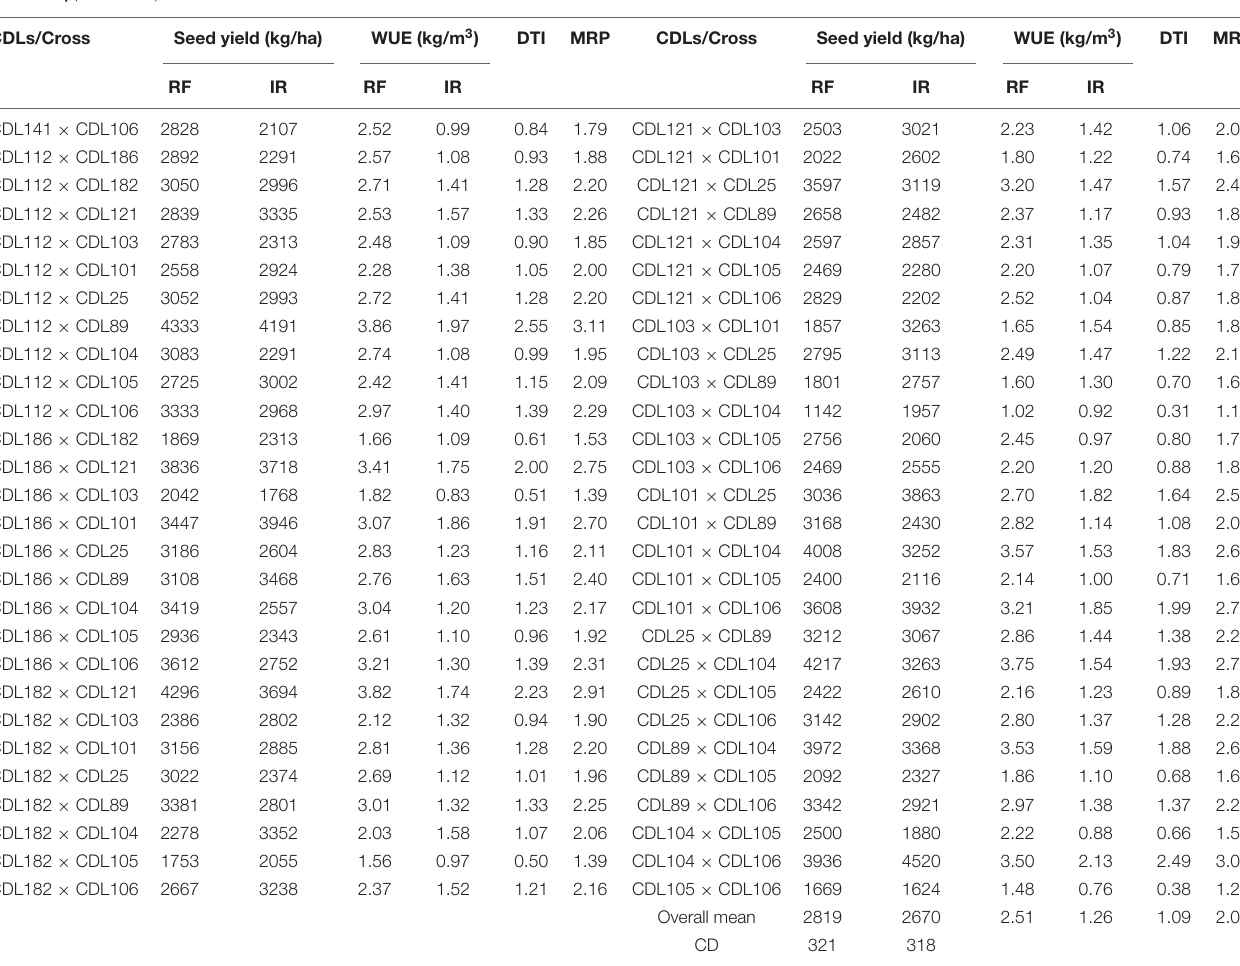
In the present study, some of the B. carinata derived lines, along with their hybrids, observed reduced performance for seed yield under irrigated than in rainfed conditions. This